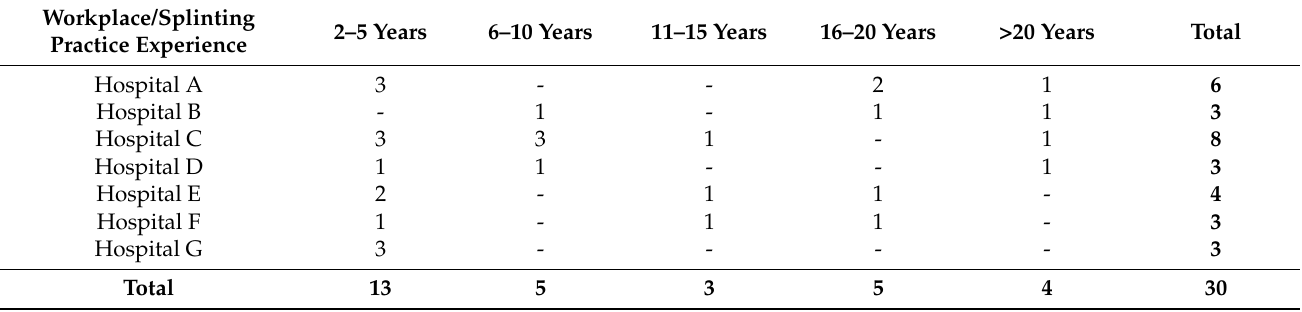
Table 1. Demographic data of the survey participants ( n = 30).